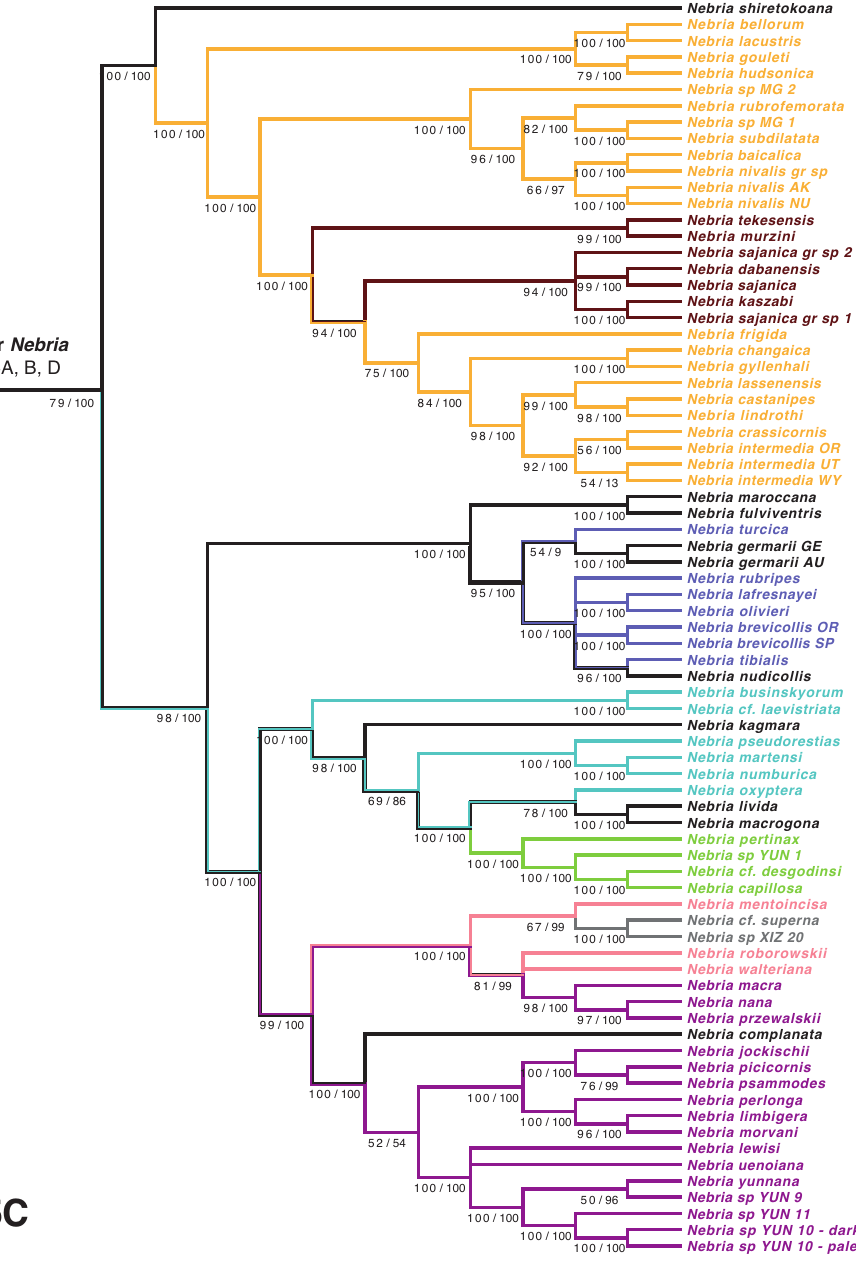
Figure 5. 16S-ND1 show weak support. Conversely, a clade including only Nippononebria and Nebria (Chart 1, line 13) is unsupported, except weakly so by the 28S single gene analysis (MLB = 41). Monophyly of Nippononebria (including both Nippononebria